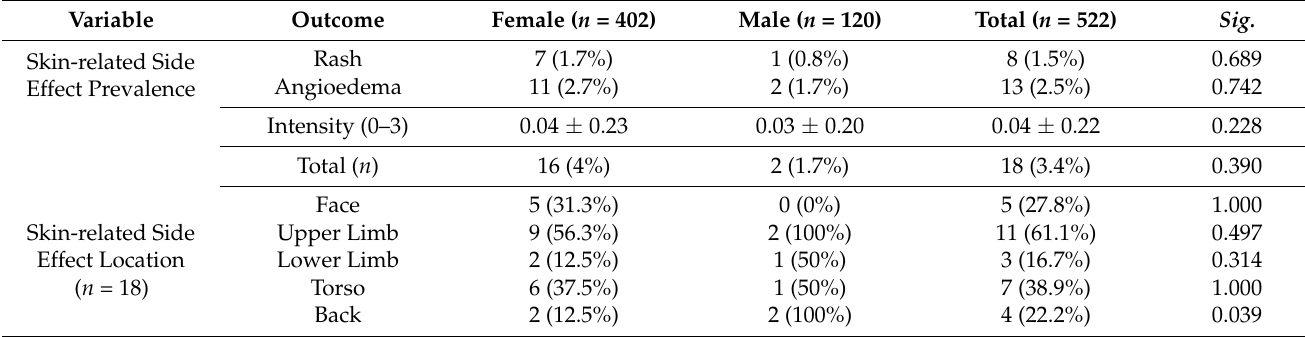
Table 8. Skin-related side effects of Slovak healthcare workers who received BNT162b2 and stratified by gender, February– March 2021 ( n = 522).